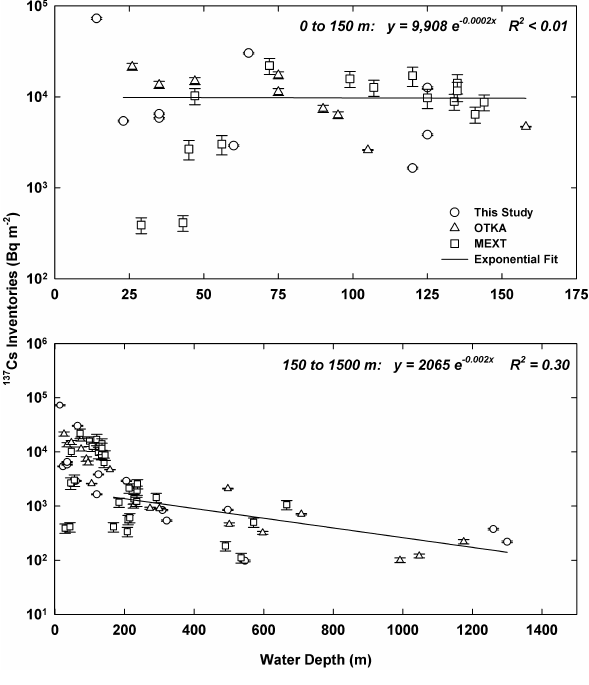
Figure 6. Spatial variations in 137 Cs sediment inventories with wa- ter depth. The measured and adjusted inventories from Fig. 5 are plotted against water depth. The upper figure shows the exponential regression for core inventories from 0 to 150m, excluding core 20. The lower figure shows all inventories and the regression for cores located from 150 to